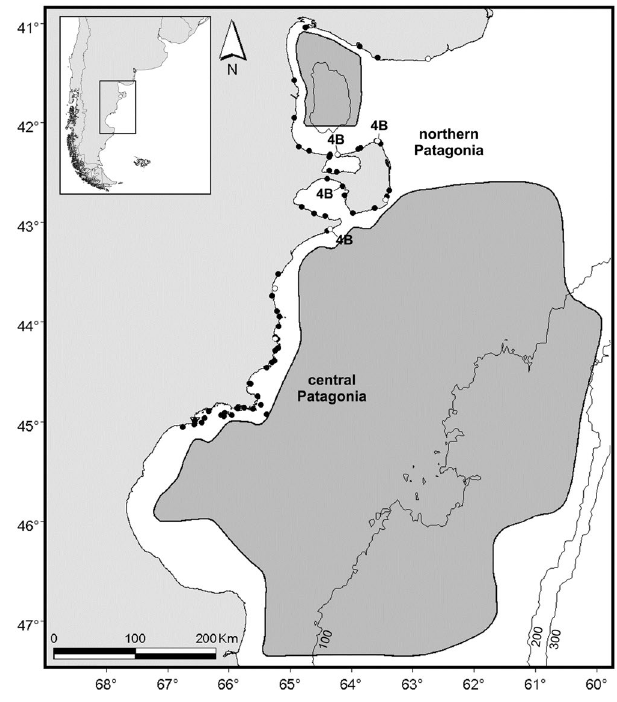
Figure 1. Detailed studied area at Patagonia Argentina with the current distribution of Otaria flavescens colonies. ○ : rookeries commercially exploited, ● : other colonies, 4B: four key and historically important breeding colonies. Grey polygons indicate area of operations of the trawling fishery in northern and central Patagonia, where bycatch rate were obtained. Map generated with ArcGIS 9.3, (http://www.esri.com/software/